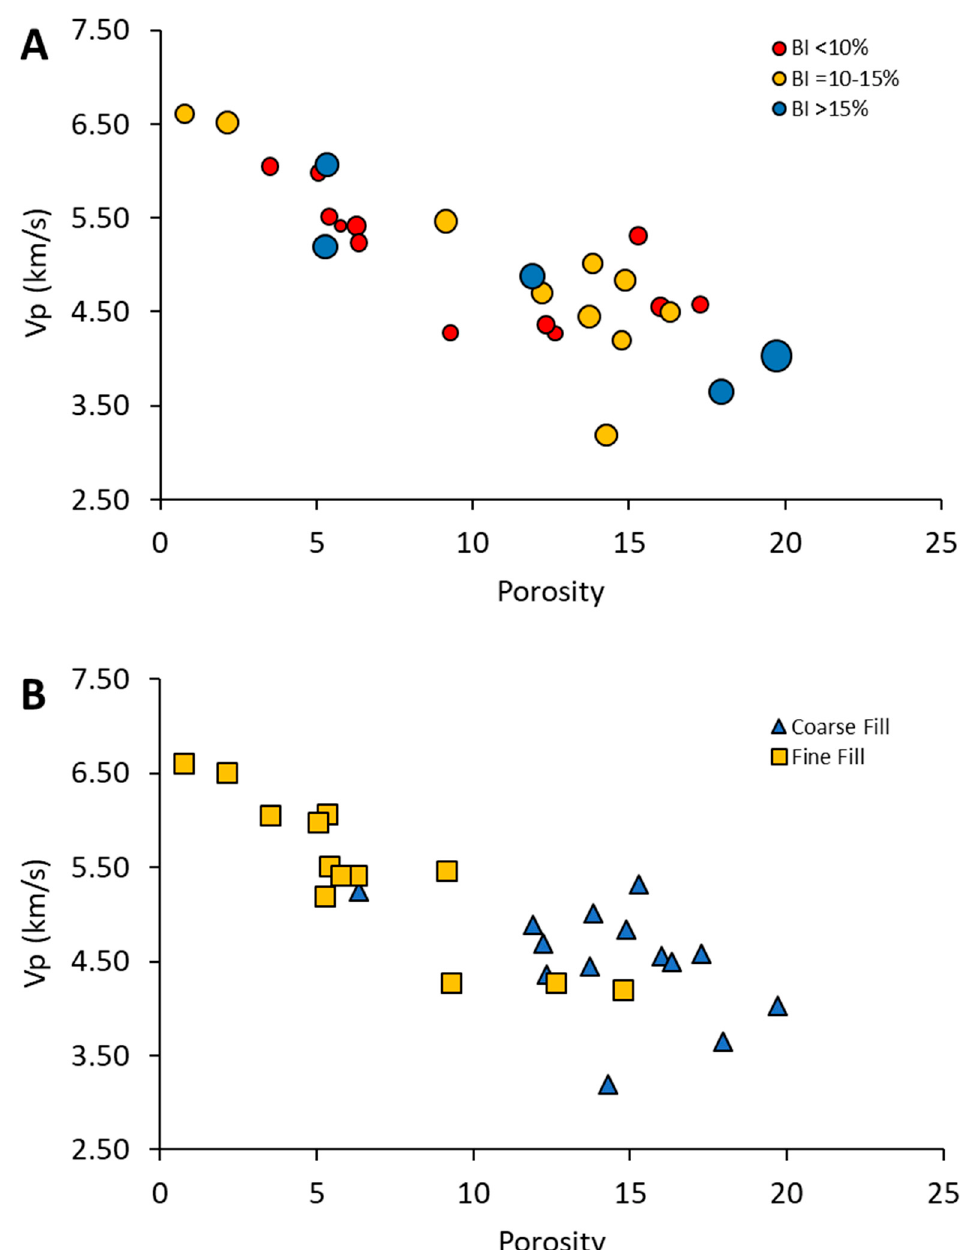
Figure 14. ( A ) Compressional velocity (V P )–porosity cross plot with bioturbation intensity superimposed. Bubble size indicates the bioturbation intensity. A wide scatter of velocities for samples with the same bioturbation intensities (at 5% and 14% porosity). ( B ) Compressional velocity (V P )–porosity cross plot with burrow filling superimposed. Samples with coarse-filled burrows have lower velocities relative to samples with fine-filled burrows.